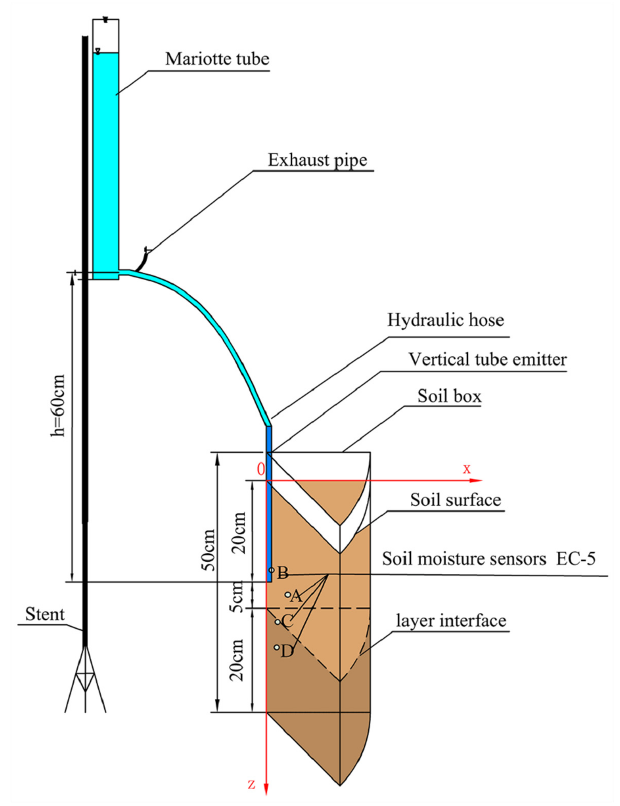
Figure 3. Laboratory experimental setup and instrumentation.